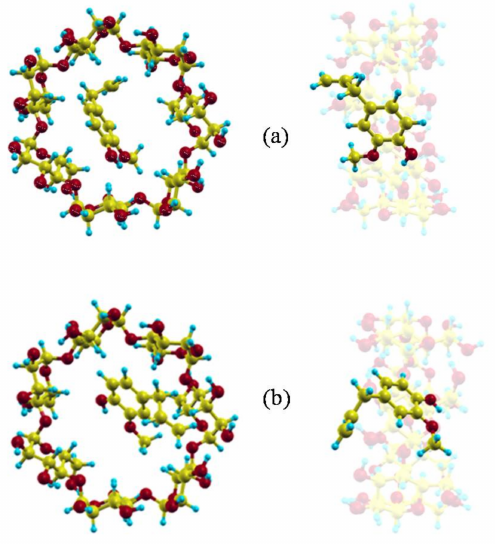
Figure 2. ( a ) The inclusion complex configuration of minimum energy and ( b ) another inclusion complex with similar energy but different